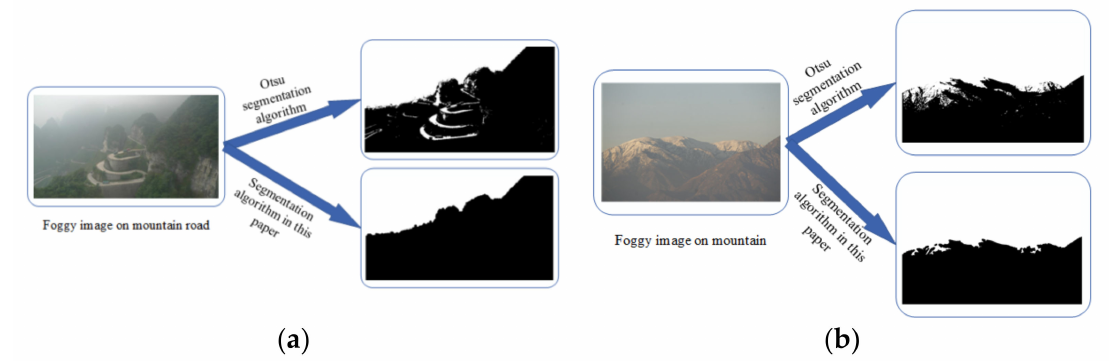
Figure 3. A comparison diagram of segmentation regions between Otsu algorithm and the proposed segmentation algorithm. ( a ) Foggy image on mountain road; ( b ) Foggy image on